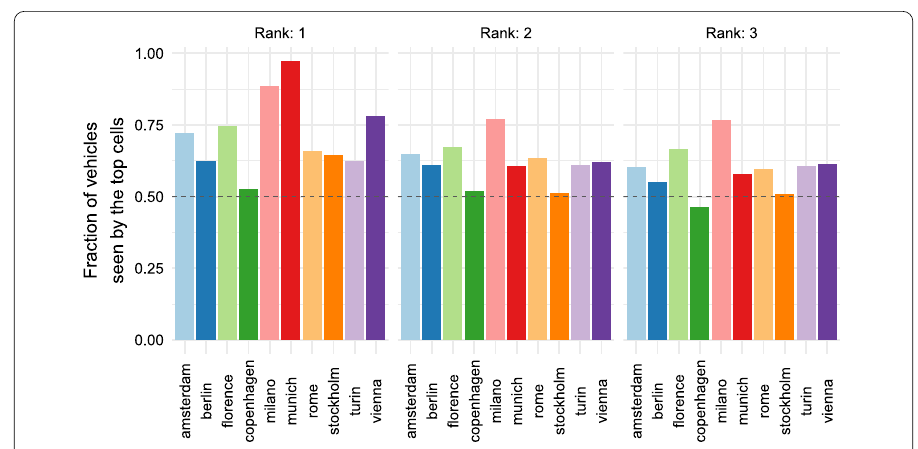
Figure 9 Potential service areas. Tolerance window: 30 days